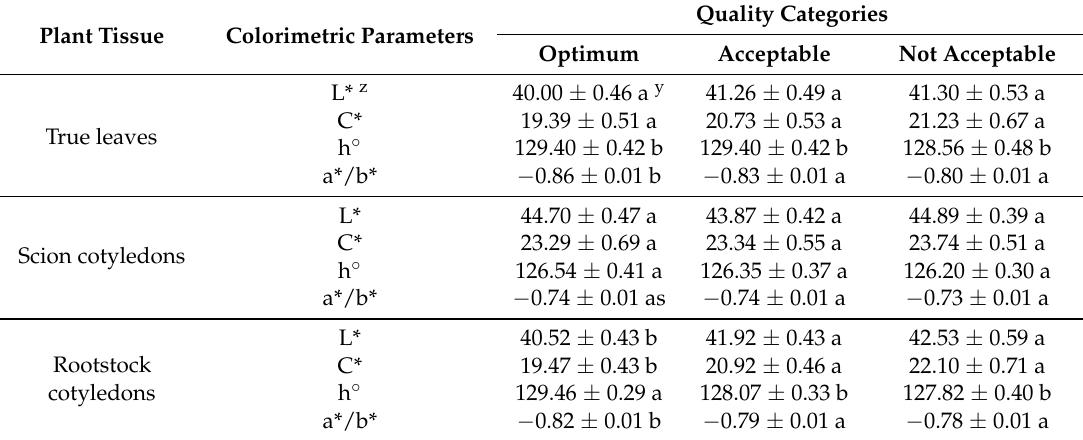
Table 5. Colorimetric parameters of grafted watermelon seedlings from two quality categories derived 14 days after